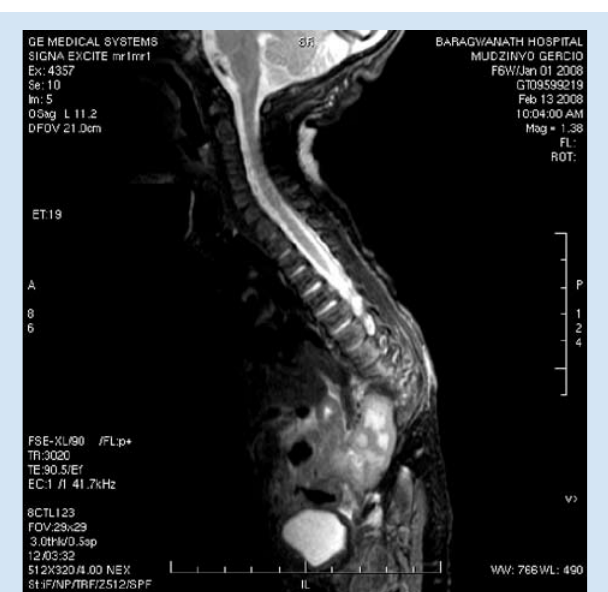
Fig. 1b. Lateral spinal X-ray demonstrates absent T12 and lumbar vertebrae.